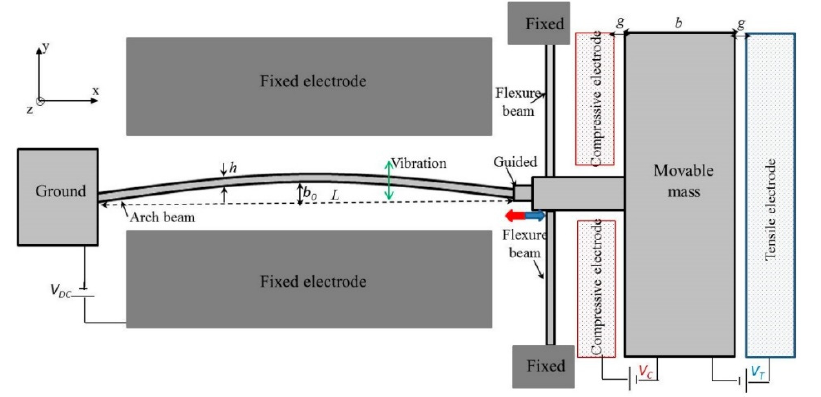
Figure 8. Schematic of the resonators with electrostatic actuation, h—beam thickness, L—beam length, g—gap size, b—width of movable mass. Adapted from [83].